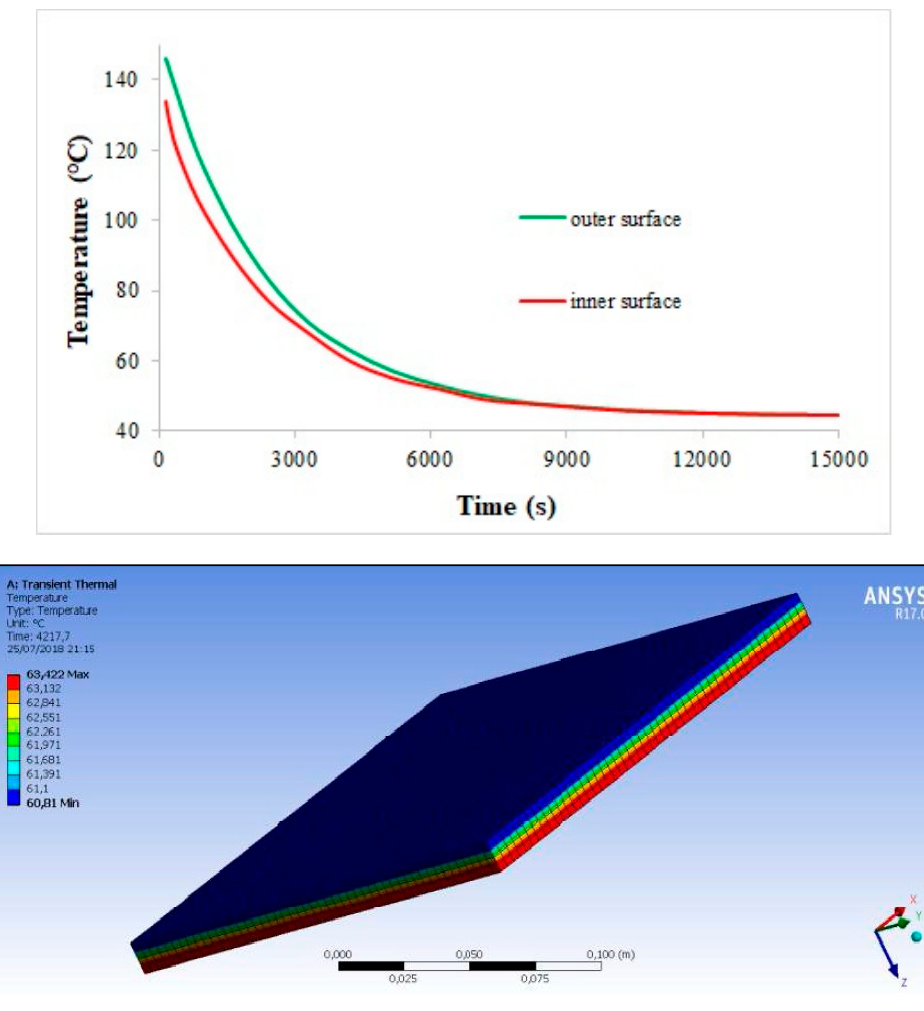
Figure 15. FEM simulation: temperature variation in the cold phase, during the thermal cycle ( up ) and along the structure thickness at fixed time ( down ).